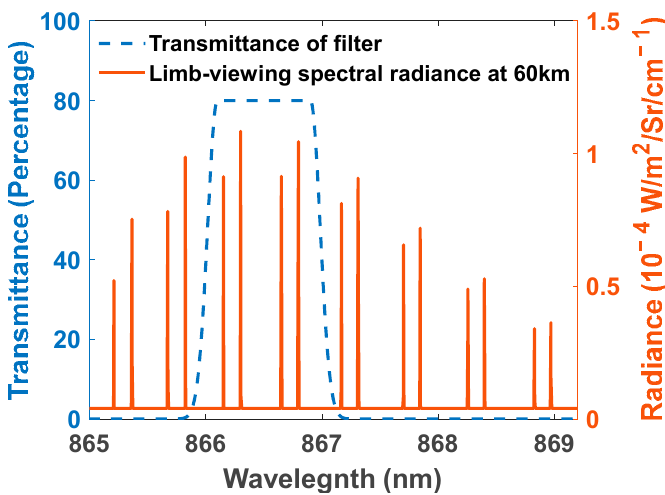
Figure 7. Spectral characteristics of the filter and target airglow.